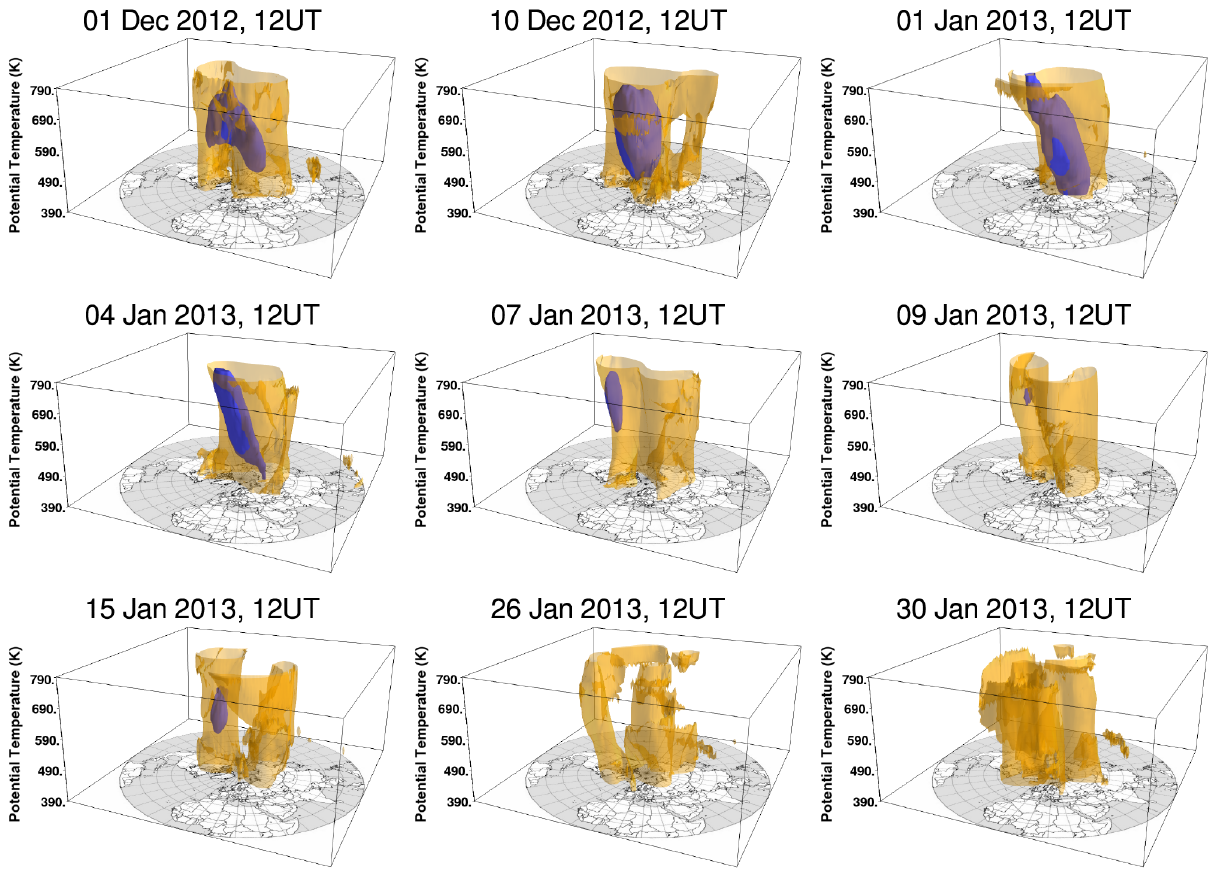
Figure 1. Isosurfaces of T NAT (blue) and the vortex edge (orange). The vortex edge is defined by the altitude-dependent sPV profile described in Sect. 2.3.1. An animation covering the 2012/13 winter is available as a